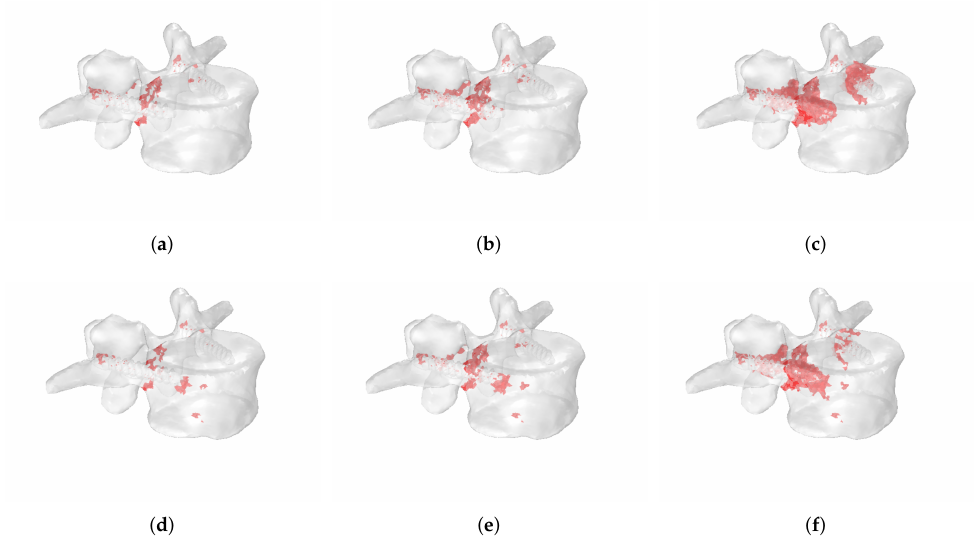
Figure 14. Fracture evolution of an osteolytic ( a – c ) and osteoblastic ( d – f ) lesion of 10 mm of radius located in P2 in a bending loading condition using a stress-based criterion. Failed elements are highlighted in red